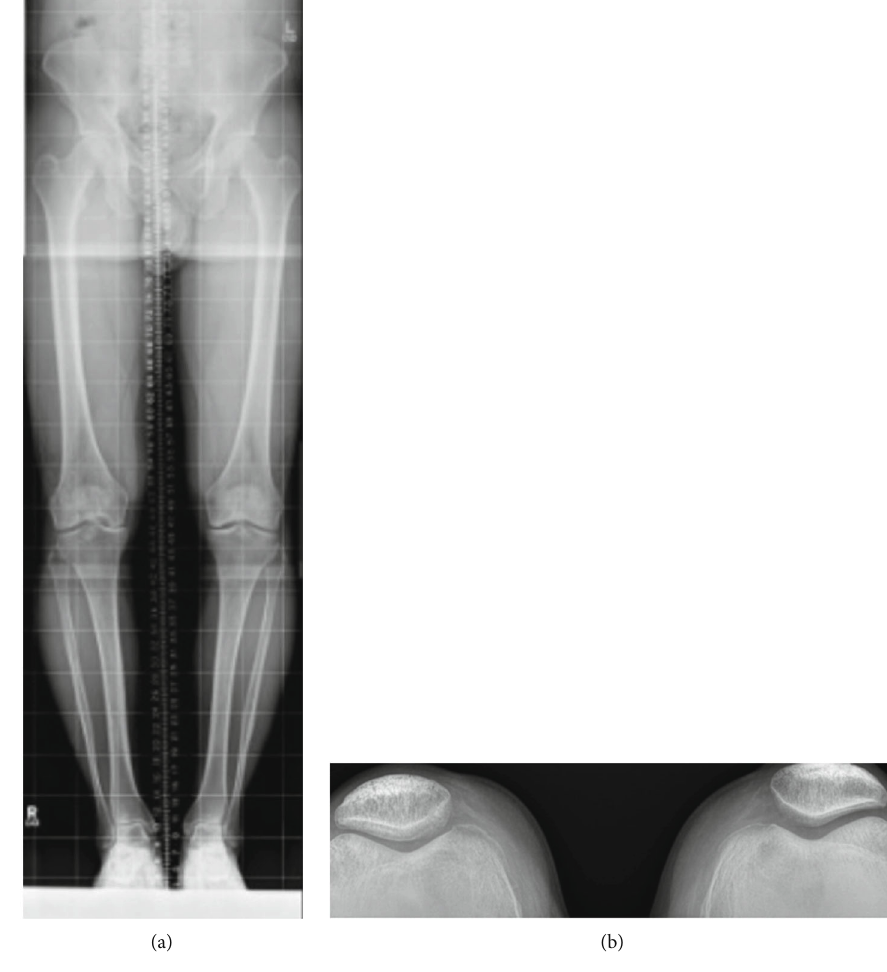
Figure 3: (a) Hip-to-ankle views. (b) Merchant ’ s patellofemoral view.